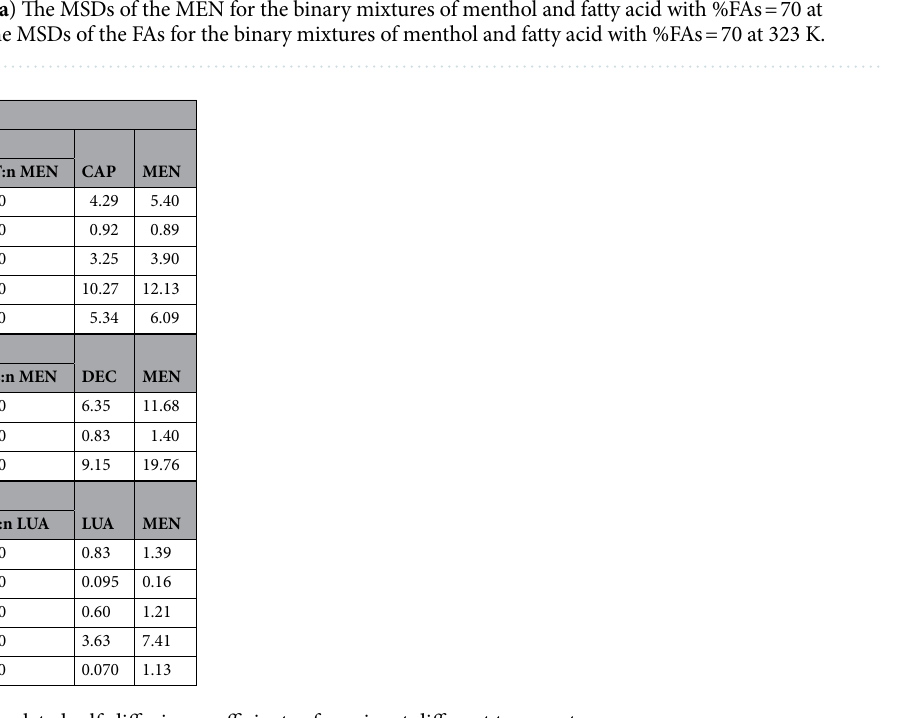
Table 2. Calculated self-diffusion coefficients of species at different